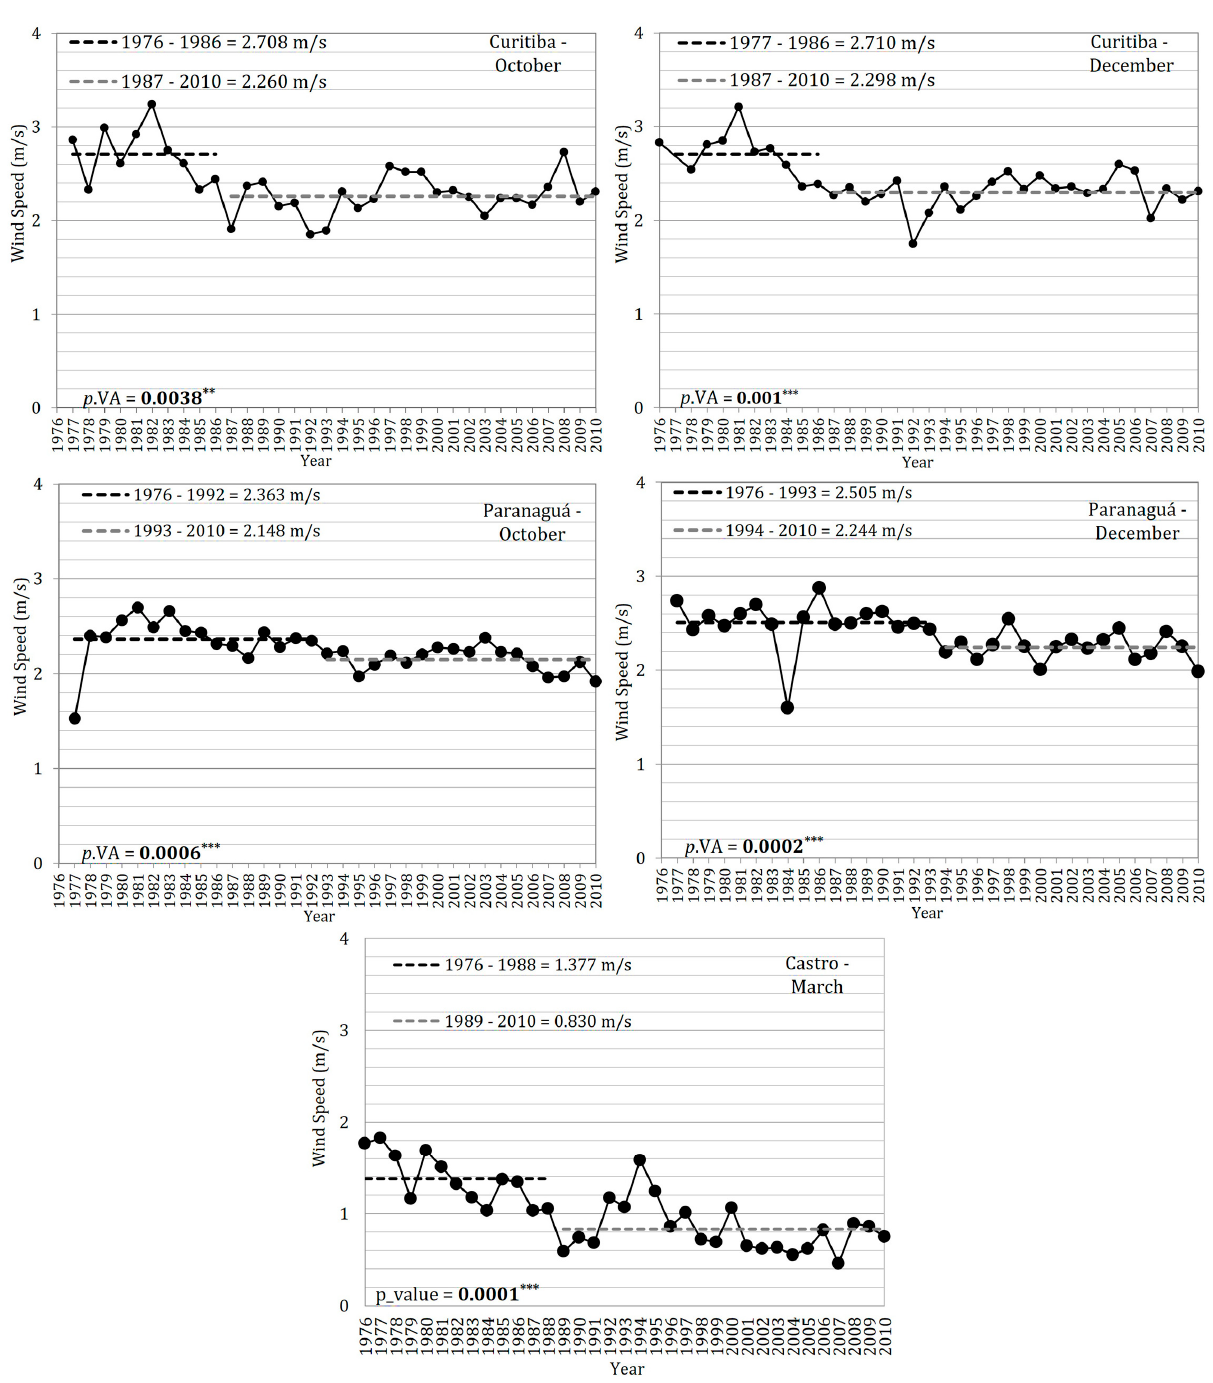
Figure 7. Representation of ruptures (Pettitt test) verified in time series of seasonal wind speed (m/s) in Curitiba and Paranaguá (Paraná, Brazil). Legend: *** = 99.9% signi fi cance; ** = 99% signi fi - cance; * = 95% signi fi cance; + = 90% signi fi cance; p .VA = signi fi cance level. In bold the results with statistical signi fi cance.